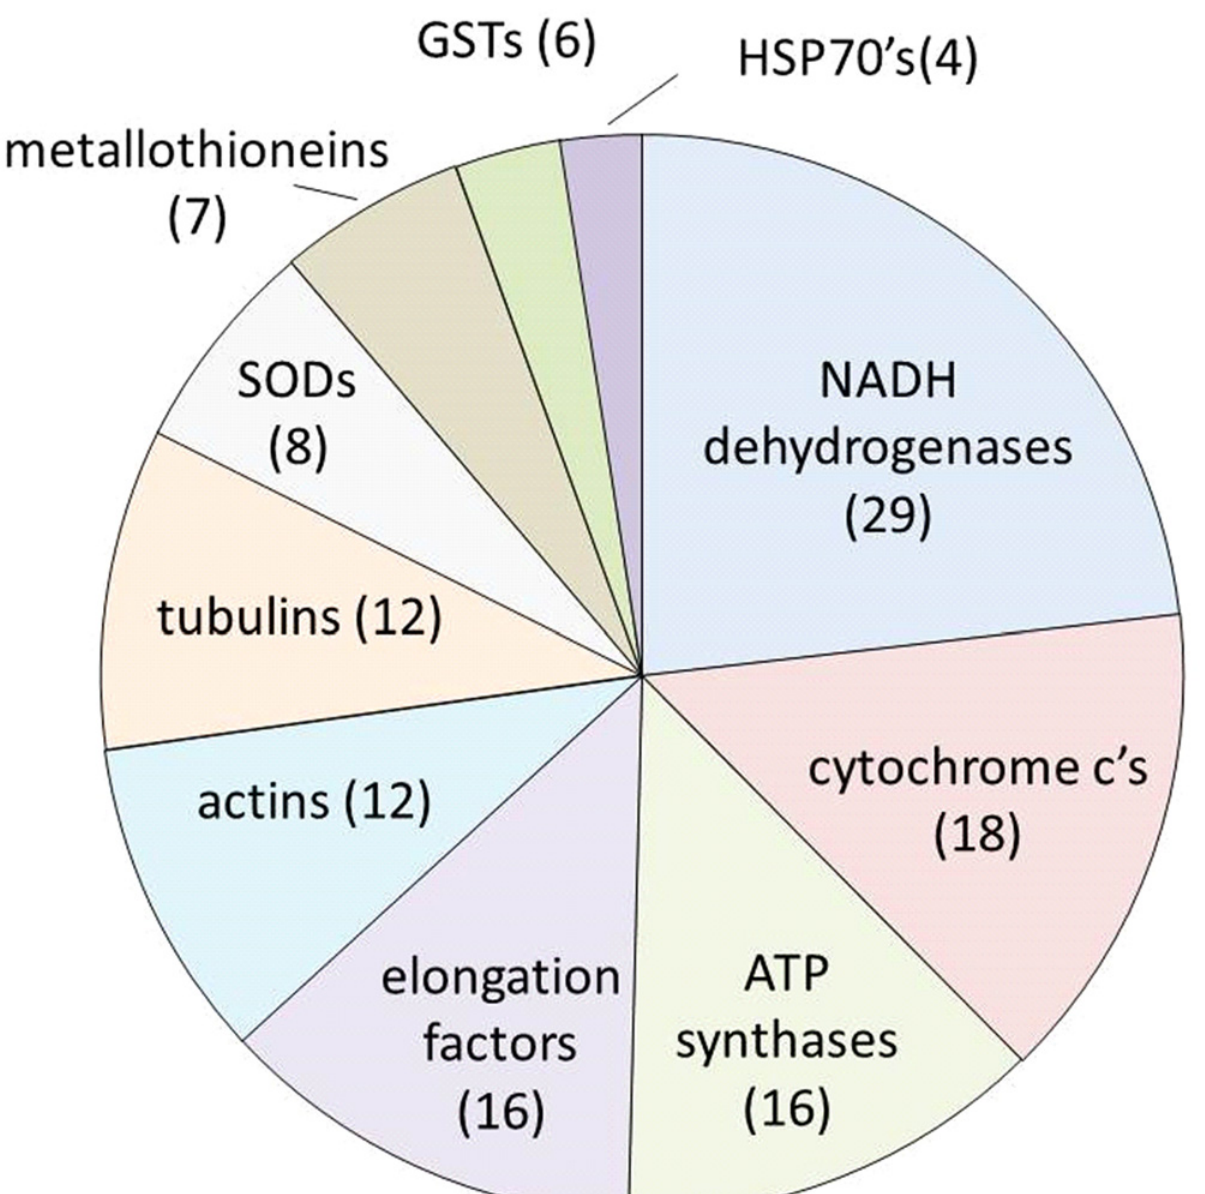
Fig 5. The ten most common differentially expressed genes identified by “ name ” (comprising more than one accession number) in oysters exposed to 10 different types of environmental stressors. Numbers in brackets represent the number of times this gene name appeared as differentially expressed in all of the different stress treatments. These data do not include genes encoding ribosomal